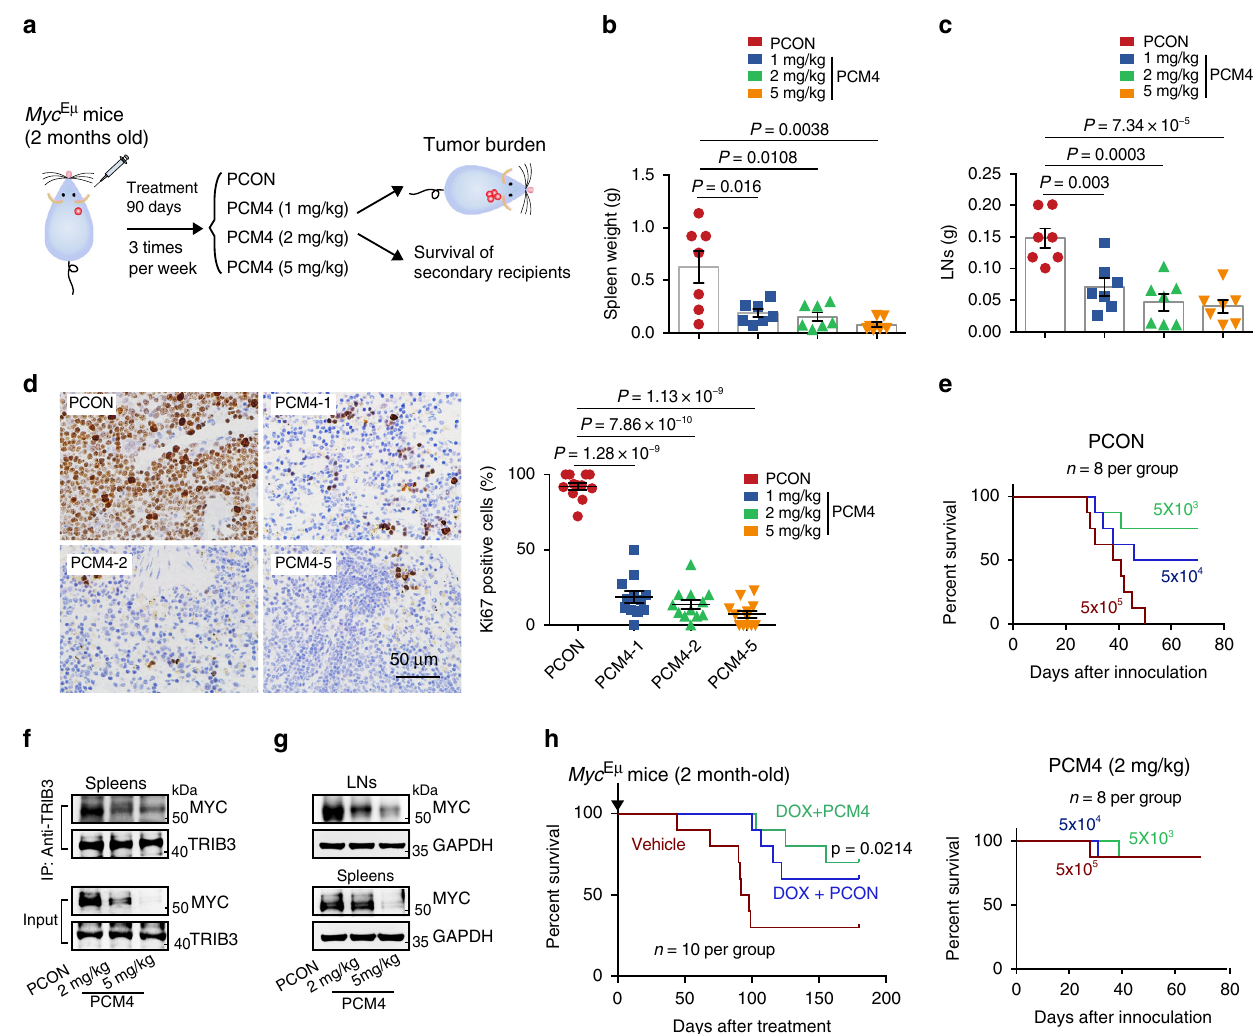
Fig. 7 Disturbing the TRIB3/MYC interaction attenuates lymphoma in mice. a The strategy for investigating the anti-BCL effects of PCM4 on Myc E μ mice in vivo. b , c The data represent the statistical analyses of spleen and LN weights in Myc E μ mice (5 months old; n = 7 per group) treated with the indicated agents. Data are represented as means ± SEM. Statistical signi fi cance was determined by two-tailed Student ’ s t test. P value: 0.016; 0.0108, and